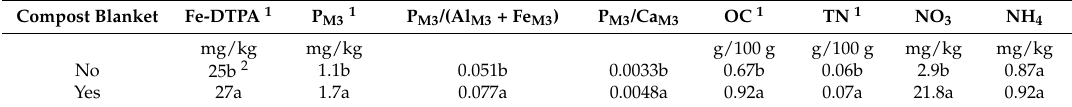
Table 3. Properties of soil mixes with or without compost blankets averaged across soils. Compost Blanket Fe-DTPA 1 P M3